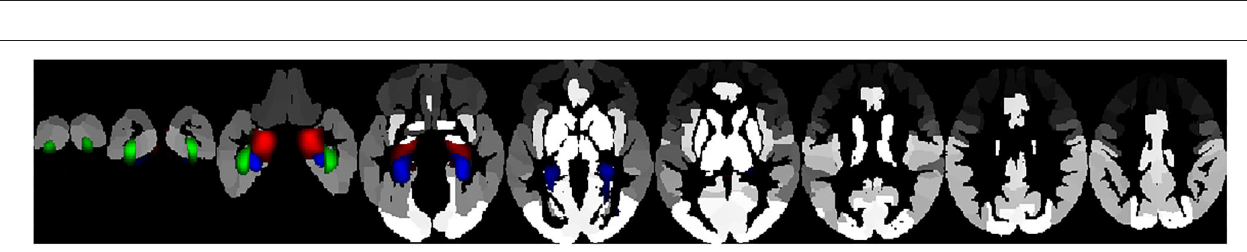
development of stress-related disorders (Gilbertson et al.,